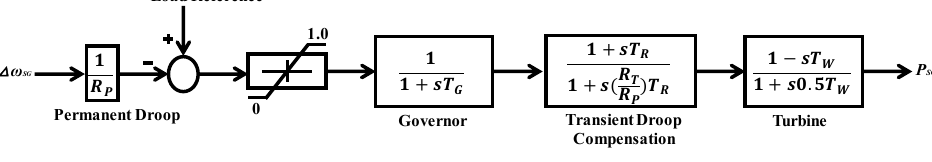
Figure 13. Steam turbine governor model.